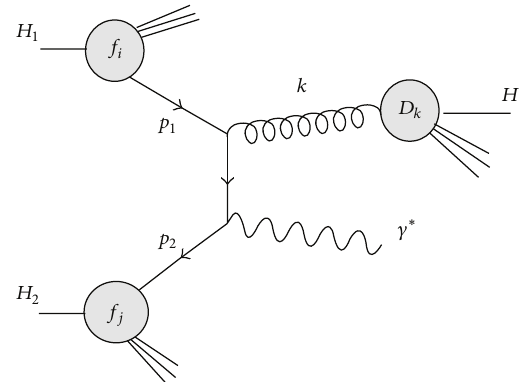
Figure 1: Example of diagram contributing to hadron production in the central fragmentation region to order O (𝛼 𝑠 ) in